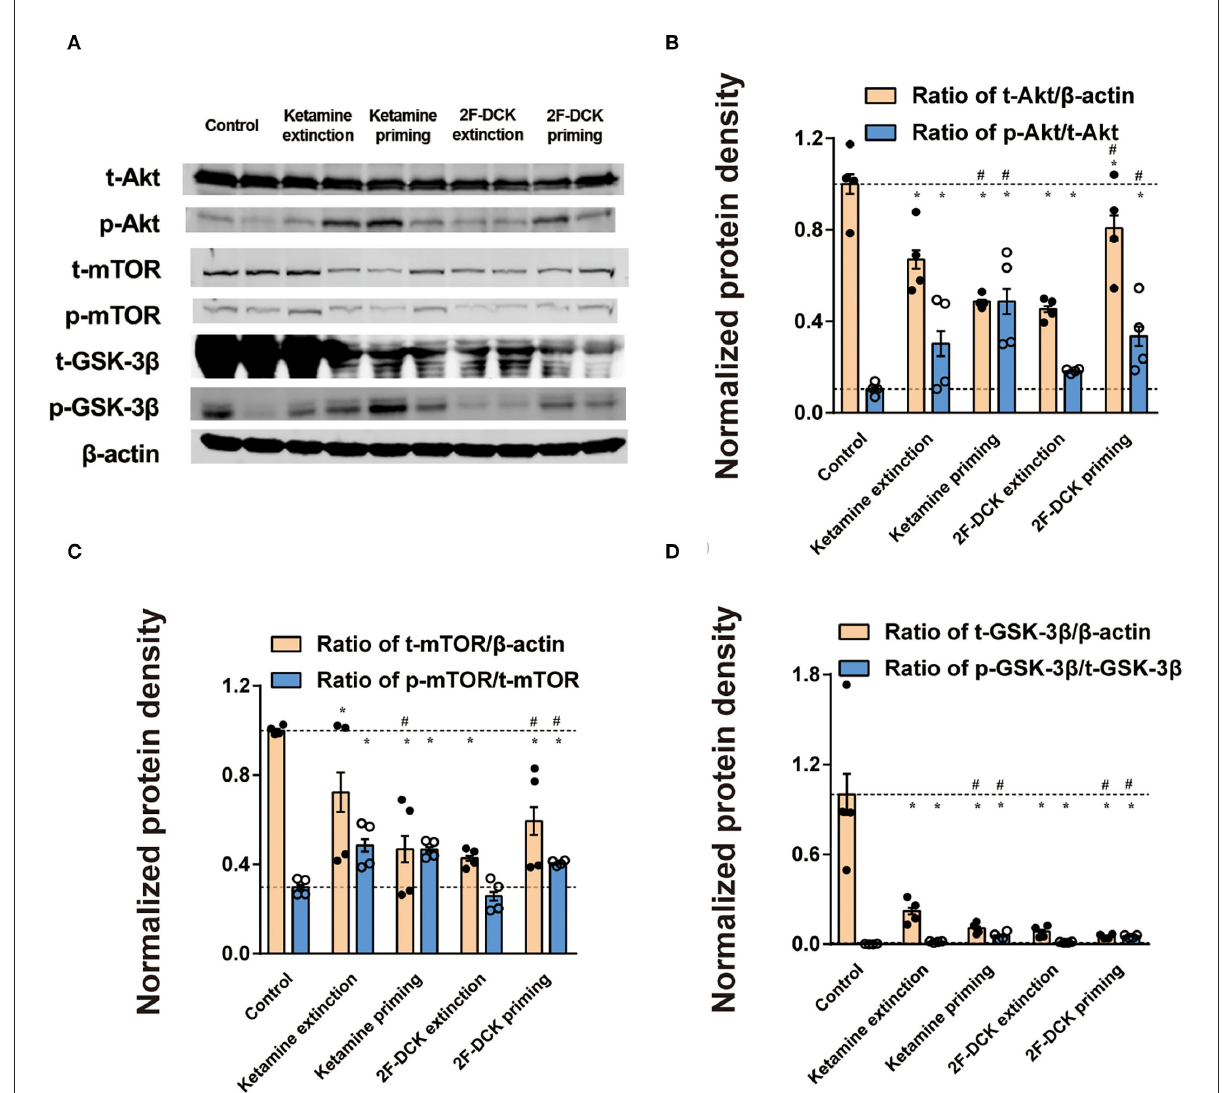
FIGURE5 Expression of Akt, mTOR, and GSK-3 β , and their phosphorylation in the NAc during the extinction and reinstatement. (A) Representative bands of Akt, mTOR, GSK-3 β , and their phosphorylated forms, and quantification of Western blot bands ( n = 4), with each bar representing the mean ± SEM. (B) The histogram shows the relative expression of t-Akt/ β -actin and p-AKT/ t-Akt. (C) The histogram shows the relative expression of t-mTOR/ β -actin and p-mTOR/ t-mTOR. (D) The histogram shows the relative expression of t-GSK-3 β / β -actin and p-GSK-3 β /t-GSK-3 β . * P < 0.05 in comparison with control and # P < 0.05 in comparison with